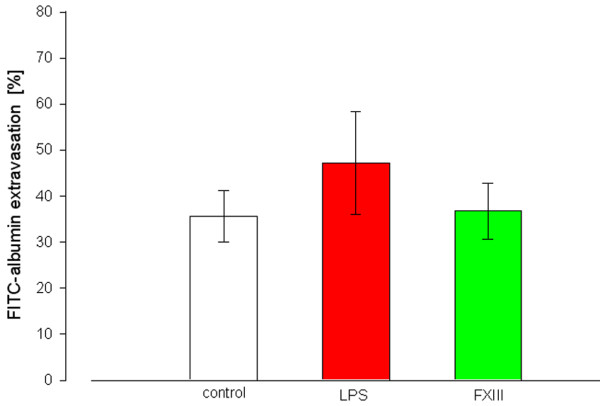
Effects of factor XIII administration on mesenteric plasma extravasation during experimental endotoxemia. Plasma extravasation after one hour of endotoxemia (mean ± SEM). Control, control group; F XIII, factor XIII treated LPS group; FITC, fluorescein isothiocyanate; LPS, untreated LPS group.